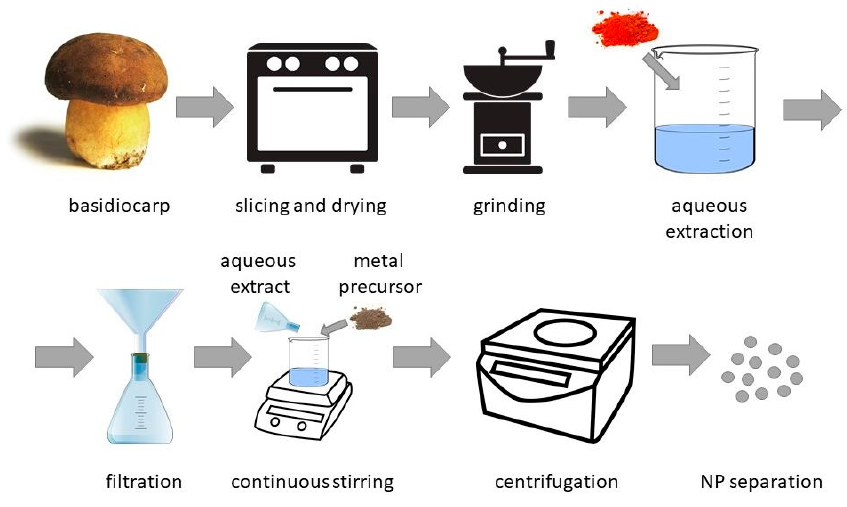
Figure 2. Graphical illustration of mycosynthesis of metal-containing NPs by basidiomycetes. Table 3. Selected examples of basidiomycetes used in the synthesis of various metal-containing NPs.